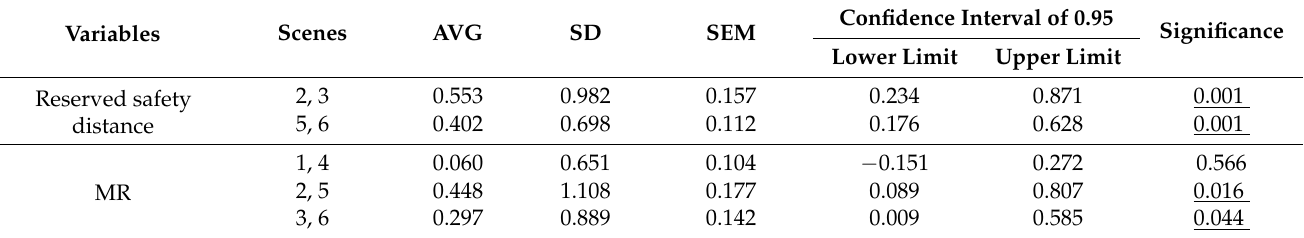
Table 9. Paired sample t -test of absolute value of longitudinal acceleration within 5 s after taking over.